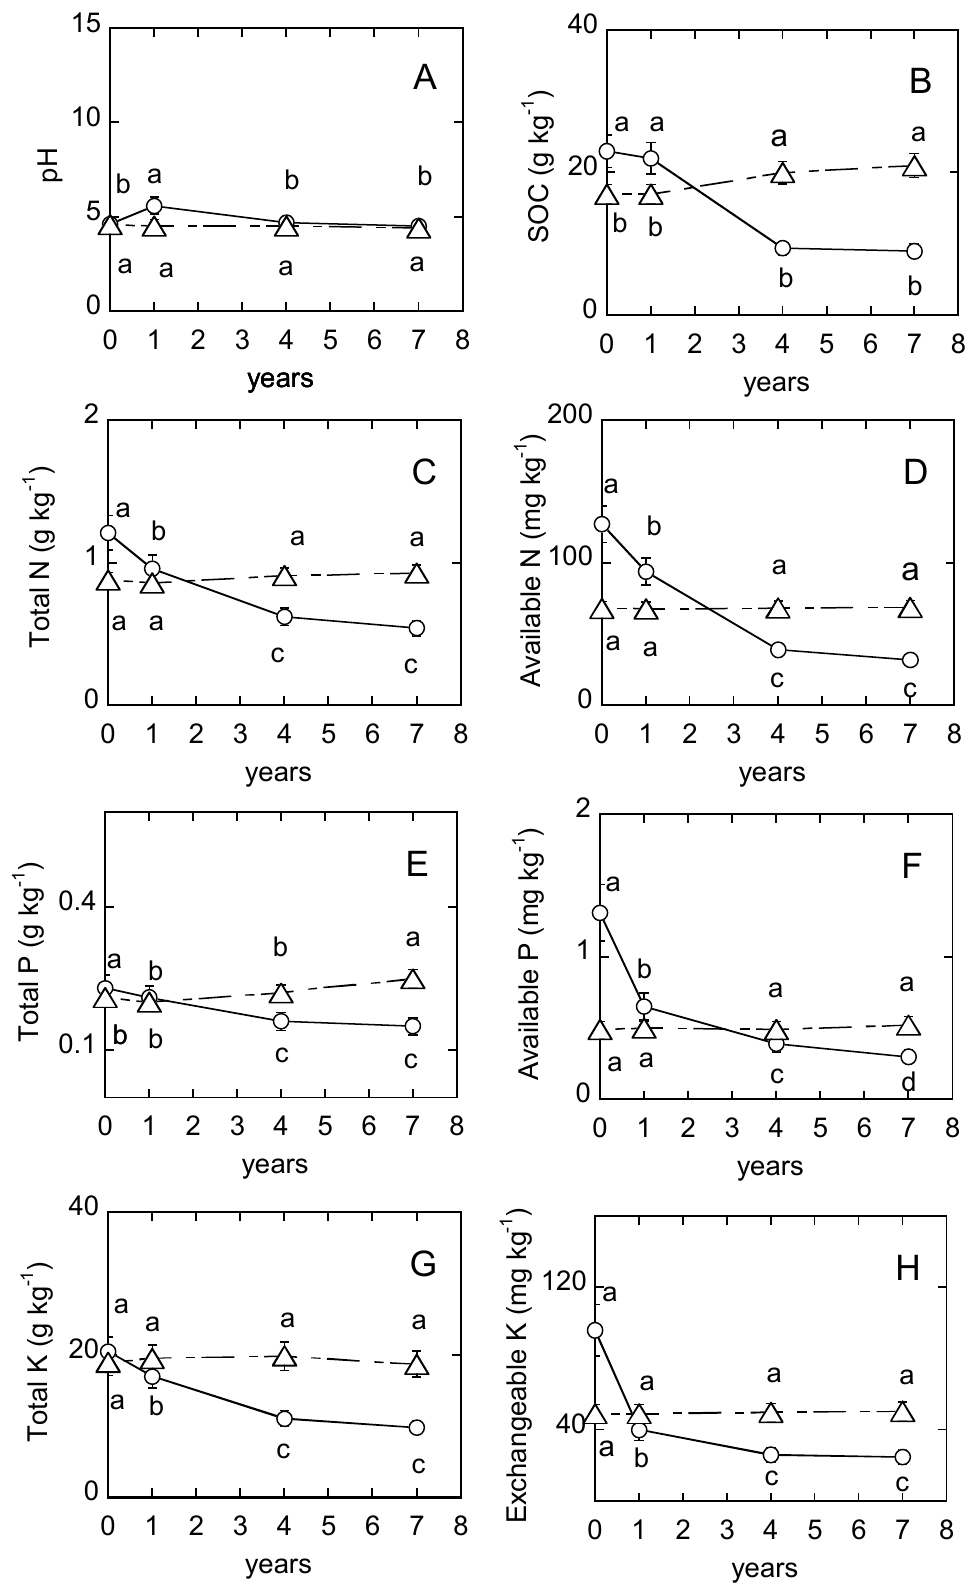
Figure 2. Soil chemical properties along a wildfire-induced time span; A , soil pH; B , soil organic carbon; C , total N; D , available N; E , total P; F , available P; G , total K; H , exchangeable K; each point represents N = 24 with the standard error of the mean indicated; ○ , burned soil; ∆ , unburned soil; standard errors are shown by vertical